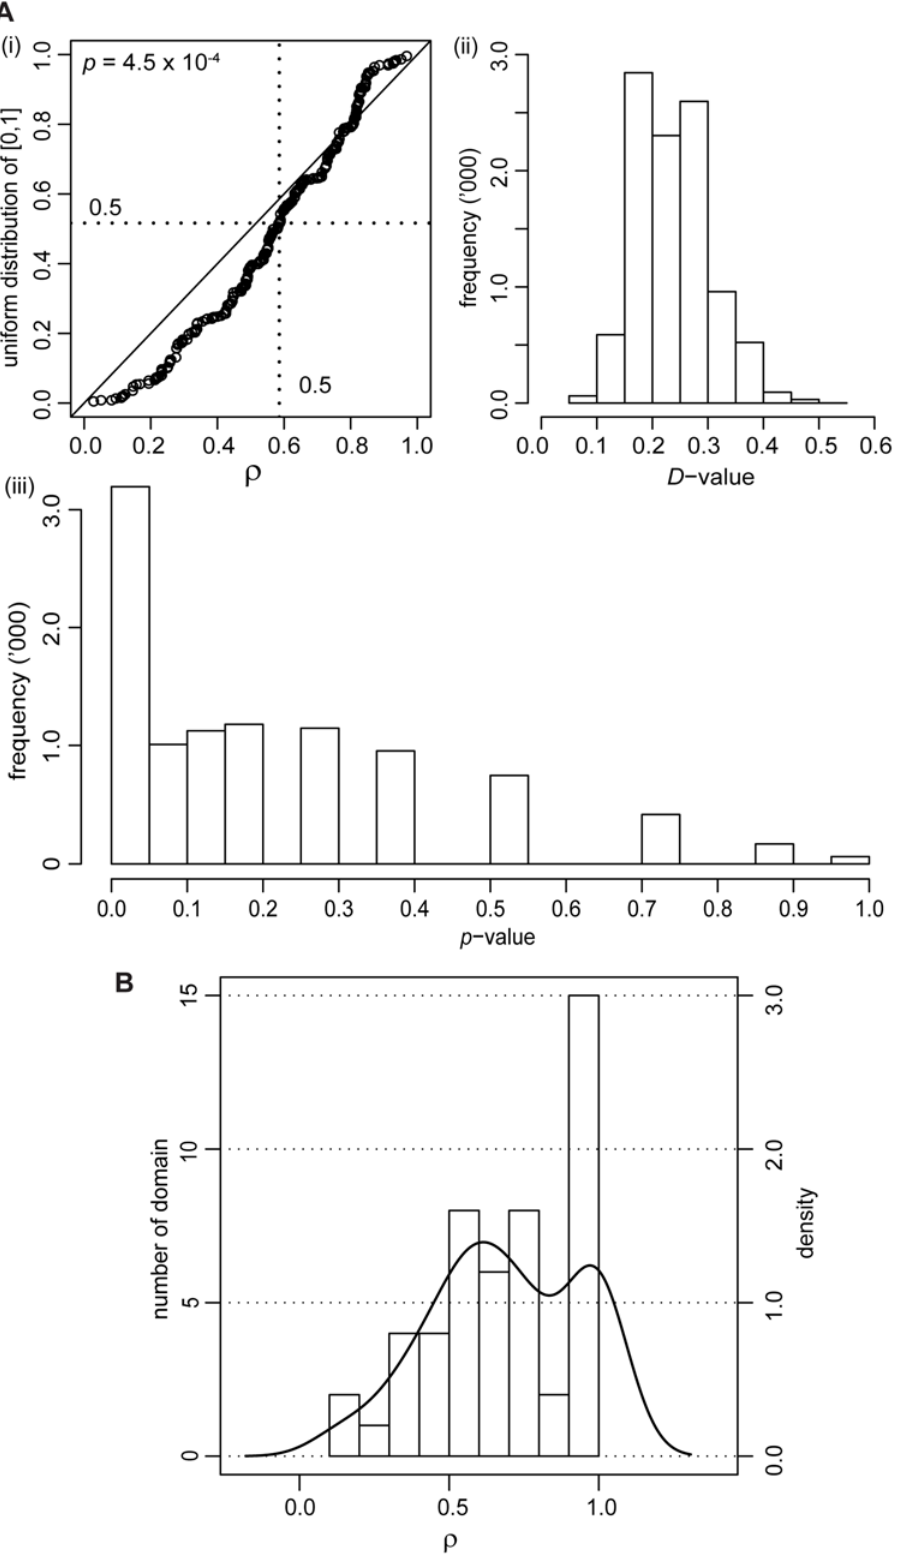
Figure 4. Distribution of r . (A) Panel (i) shows a quantile-quantile plot between all r from domain-associated breakpoints and the uniform distribution on [0,1]; n =286, excluding r =1. If the distribution of r is identical to uniform, points in the quantile-quantile plot would follow the diagonal line from (0,0) to (1,1). The dotted lines indicate quantile=0.5 on both axes. A Kolmogorov-Smirnov test was used to evaluate whether the difference between these two distributions was significant, yielding D and p values. Panels (ii) and (iii) show the distributions of D and p values that resulted from Komogorov-Smirnov tests between each of the 10,000 subsamples of the dataset and the respective uniform distribution [0,1]. (B) Distribution of r across distinctive domains, as histograms (bars) and density plot (line). Details of these domains are listed in Table S2. doi:10.1371/journal.pone.0004524.g004 PLoS ONE |